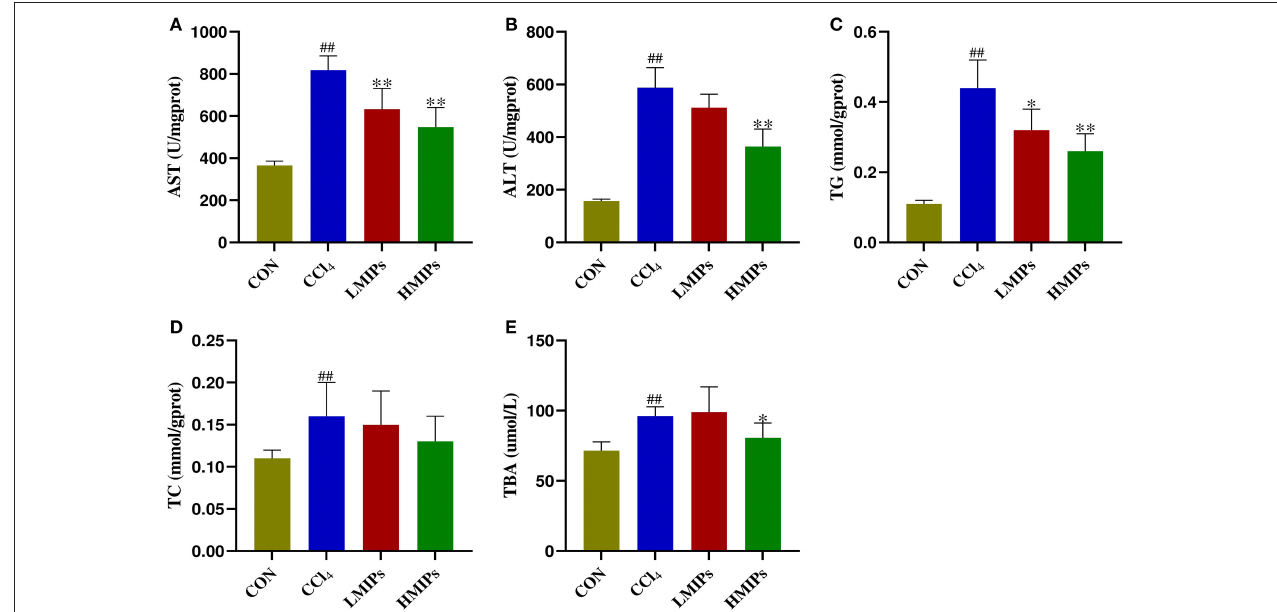
FIGURE 3 | Effect of MIP infusion on serum biochemical parameters. The content of serum aspartate aminotransferase (A) , alanine aminotransferase (B) , triglyceride (C) , total cholesterol (D) , and total bile acid (E) was determined by ELISA kits. The values are reported as the mean ± SD of six mice per group: (##) P < 0.01 compared with the control group and (**) P < 0.01 and (*) P < 0.05 compared with the CCl 4 -treated group.